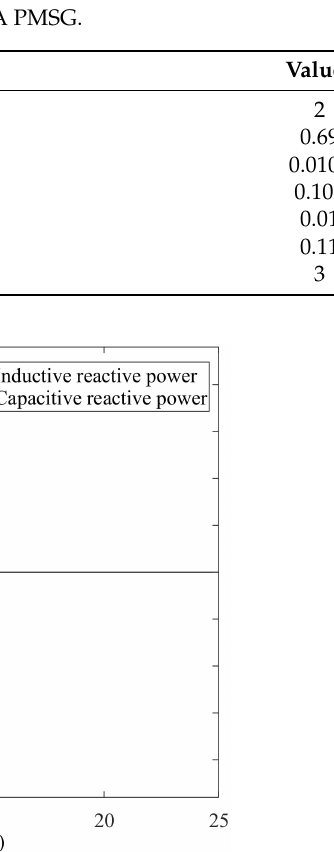
Figure 4. The measured reactive power adequacy of a 2MVA PMSG under the full wind